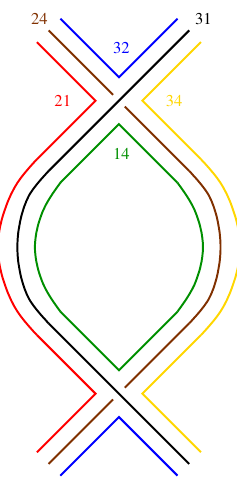
Figure 11 . The kernel K ( c 1 c 2 ) for q = 4 and ( c 1 c 2 ) = (23). When \gluing" to its right a (cid:13)uctuation g (3) , with for example the a indices on top and the b indices at the bottom, the indices a 31 a 32 a 34 b 31 b 32 b 34 of color 31 and 34 are traced, while the index of color 32 is